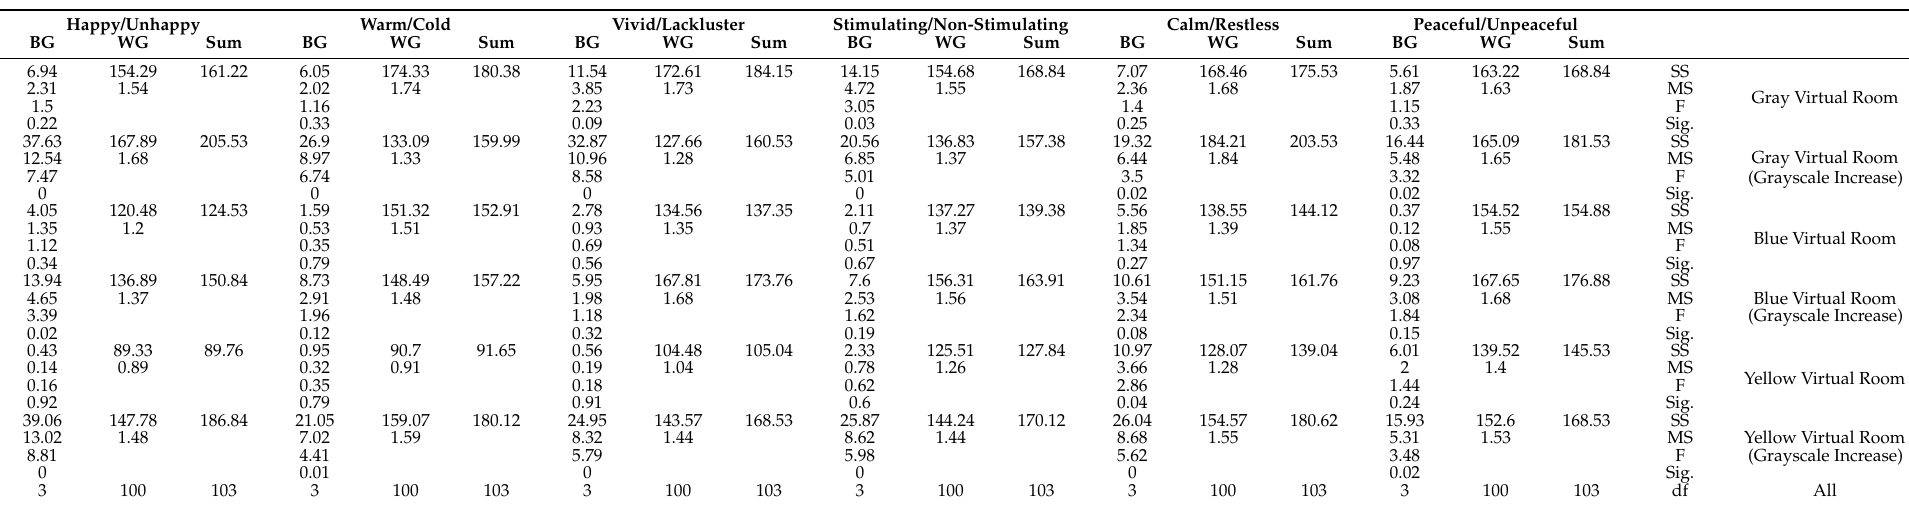
Table 9. Perception of different age groups of the color of hotel internal